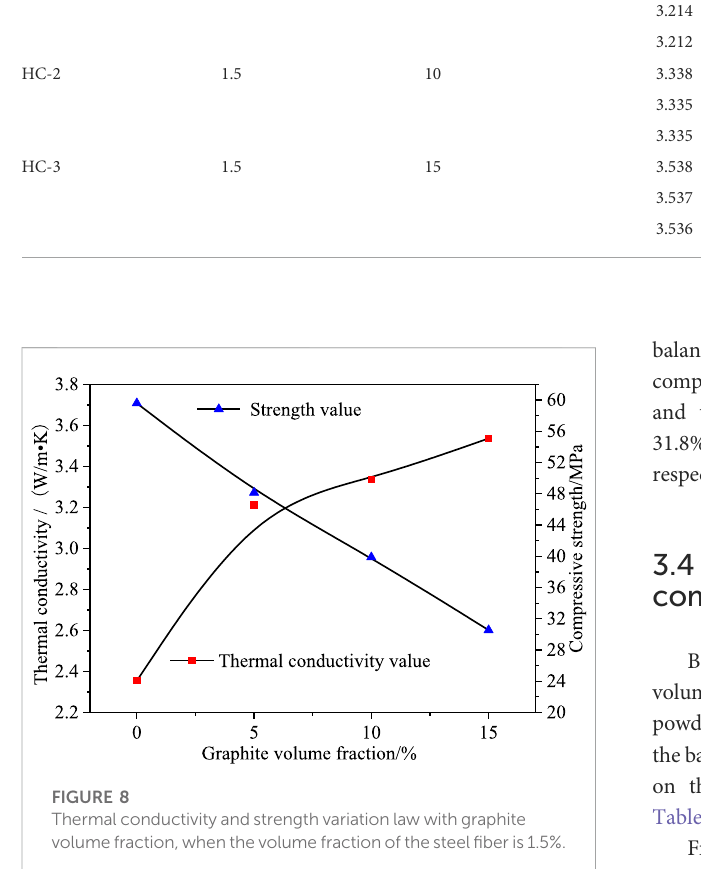
Figure 7. Thermal conductivity test values of the SFC were shown in Table 18.